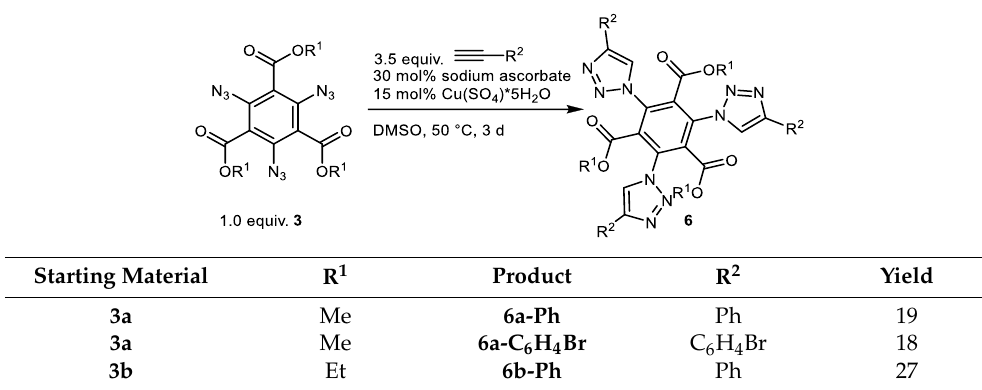
Table 3. Syntheses of tris-1,2,3-triazoles 6 .